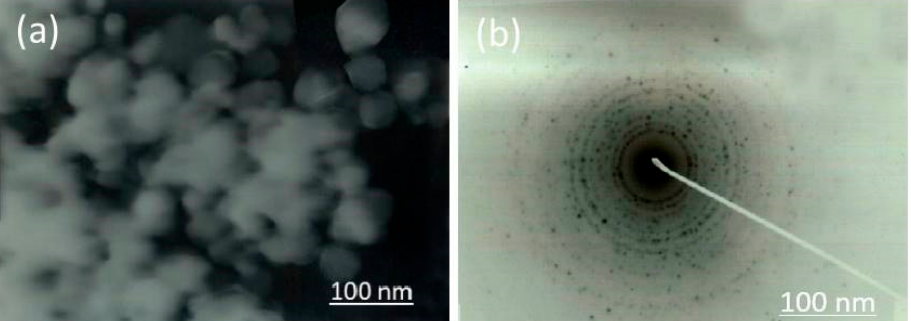
Figure 5. Transmission electron microscopic image of ( a ) TiO 2 nanoparticles synthesized by Bacillus subtilis ( b ) Selected area electron diffraction peaks.